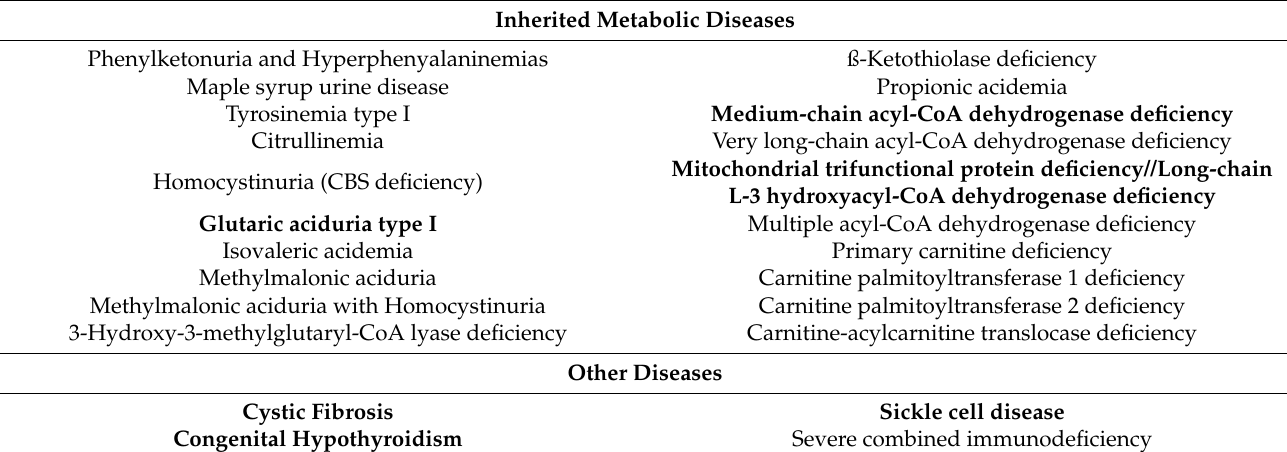
Table 1. Diseases included in the newborn screening program of